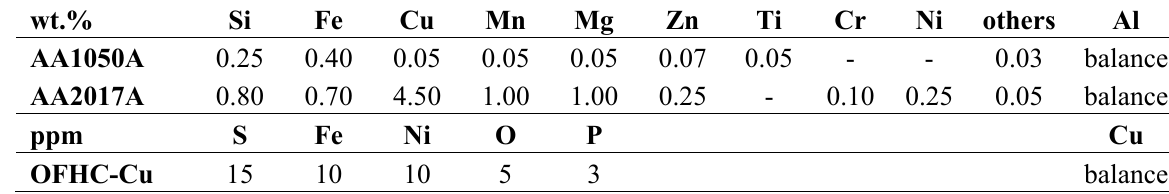
Table 3. Composition of the applied sheet materials (max. values). wt.%